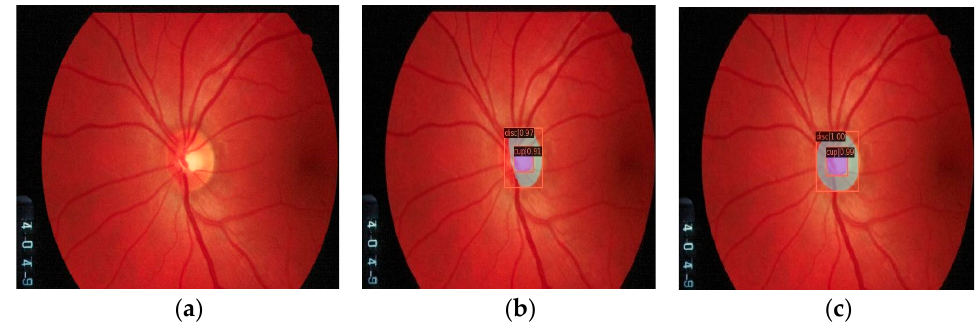
Figure 11. Segmentation on extern dataset with Cascade Mask-RCNN model. Original image from DRIONS-DB ( a ). Segmentation result from trained model with Refuge dataset ( b ). Segmentation result from trained model with G1020 dataset ( c ).